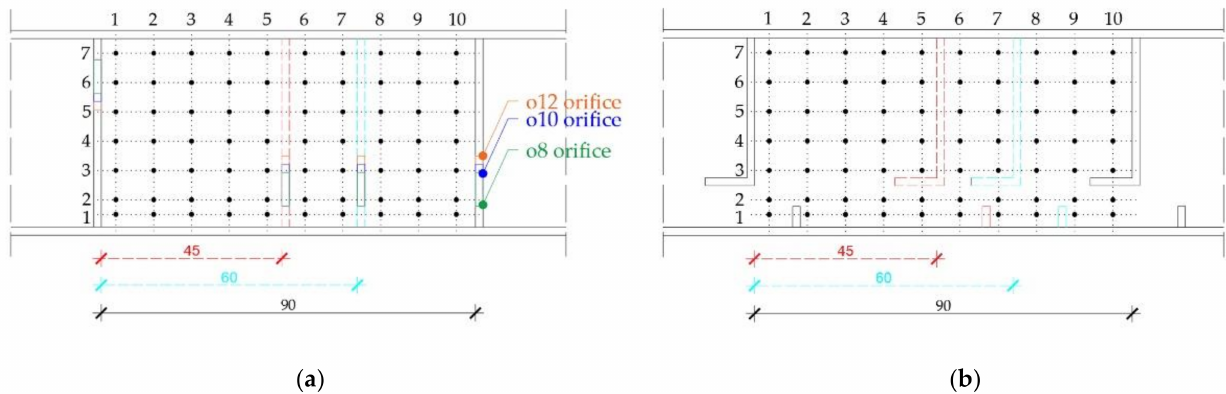
Figure 3. Model setup in the flume: ( a ) flume with the installed fishway bottom—looking downstream, ( b ) pool-orifice fishway model—looking upstream, ( c ) vertical slot fishway model—looking downstream (photos by G. Gilja).